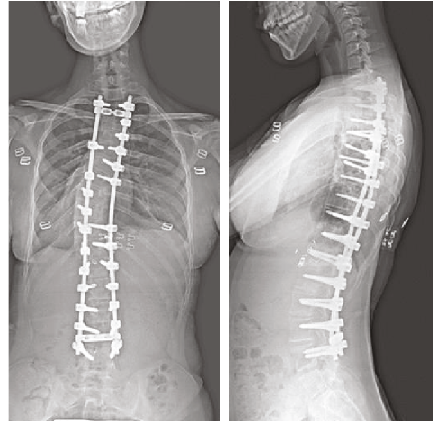
Figure 2: Case 1: postoperative radiographs (anteroposterior, lateral) 4 years after surgery show adequate curve correction and